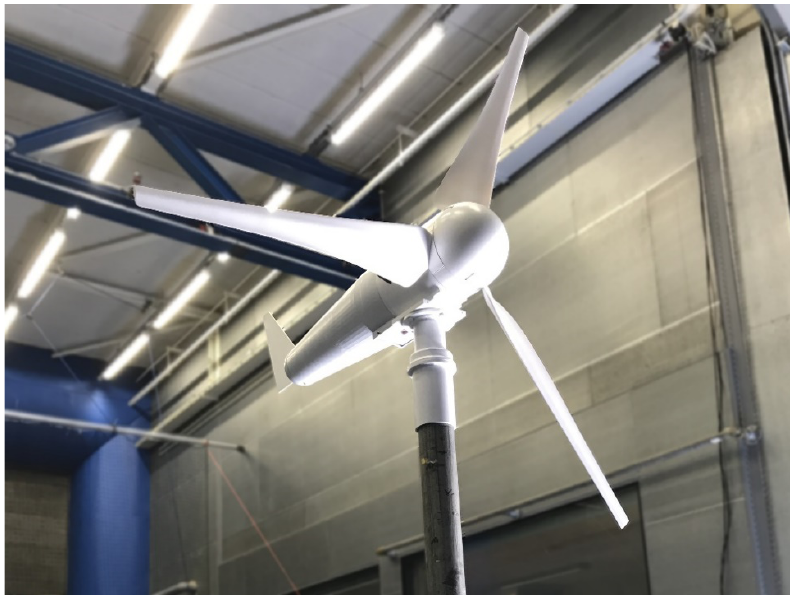
Figure 1. GUST horizontal-axis SWT prototype.